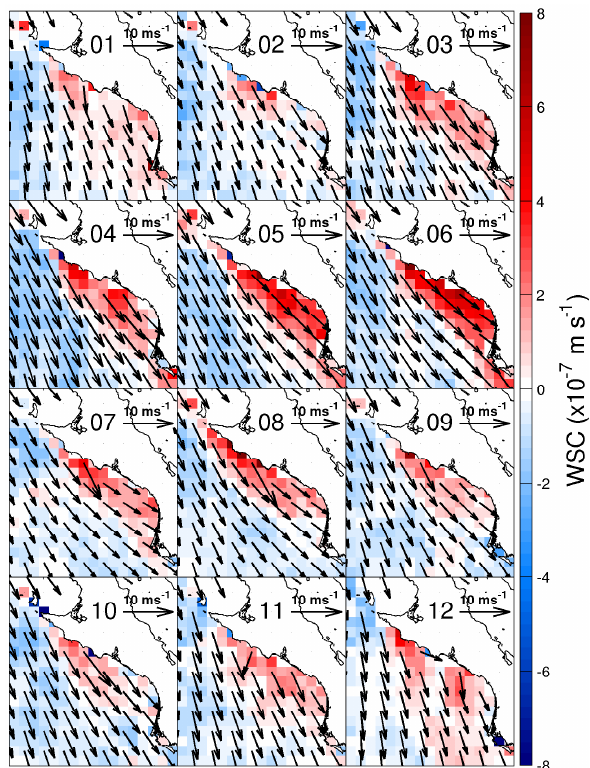
Fig. 2. Maps of monthly mean of wind features and wind stress curl (WSC) for 2003–2007. Numbers in each panel indicate the month of the year. For visualisation purposes, the vectors in each panel are plotted with half of their spatial resolution.